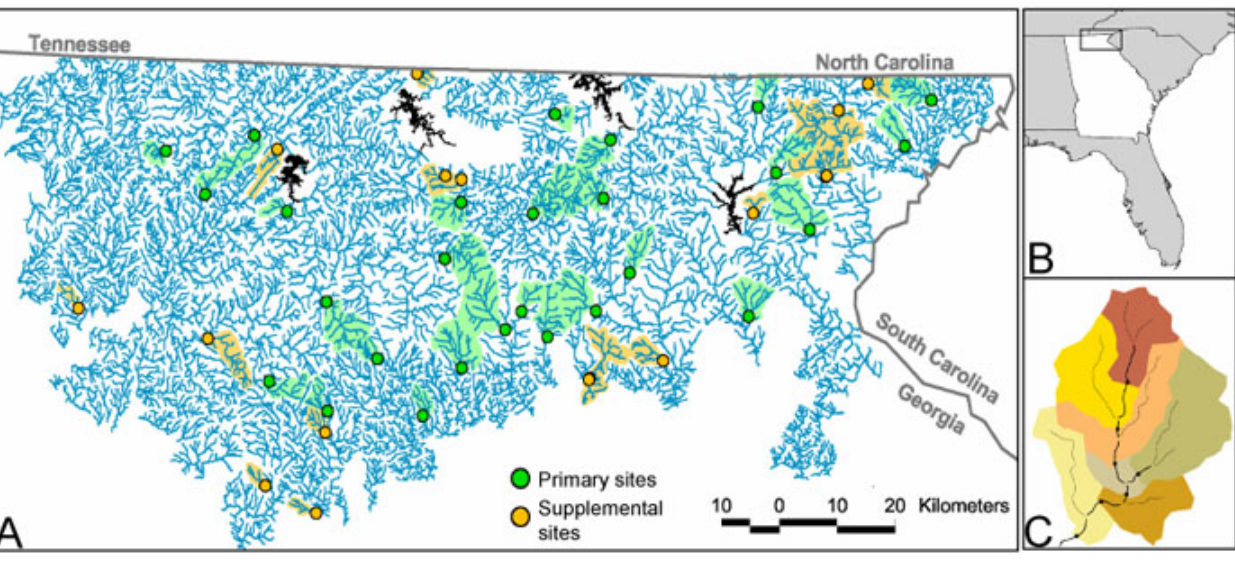
Fig. 2. Study landscape and sampling sites. A) The Georgia trout stream network as classified by the Georgia Department of Natural Resources with primary and supplemental sampling sites (described in Site Selection text). B) Location map outlining the study landscape in the northeastern corner of Georgia, USA. C) Example of a hypothetical stream network. Points denote 2 nd order or larger stream segments. For each segment 2 nd order or larger, we delineated: 1) the entire upstream catchment draining to the segment; and 2) the adjacent area, or the area along the stream segment directly draining into that segment. For example, the adjacent areas for each of the seven streams segments are denoted by different colored